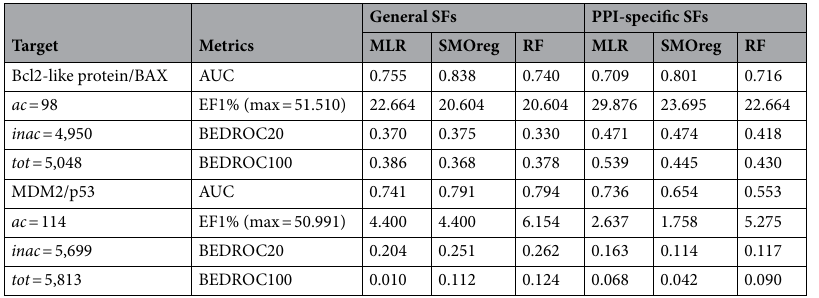
Table 6. Screening success of the general and PPI-specific scoring functions trained with MLR, SMOreg and RF evaluated on the Bcl2-like protein/BAX and MDM2/p53 datasets. ac , inac and tot are the number of active, inactive compounds and the total number of molecules in the final dataset ( i.e., compounds that were docked and rescored with DockThor and DockTScore, respectively). Only the top-scored protonation state of each compound according to each scoring function (SF) was kept.